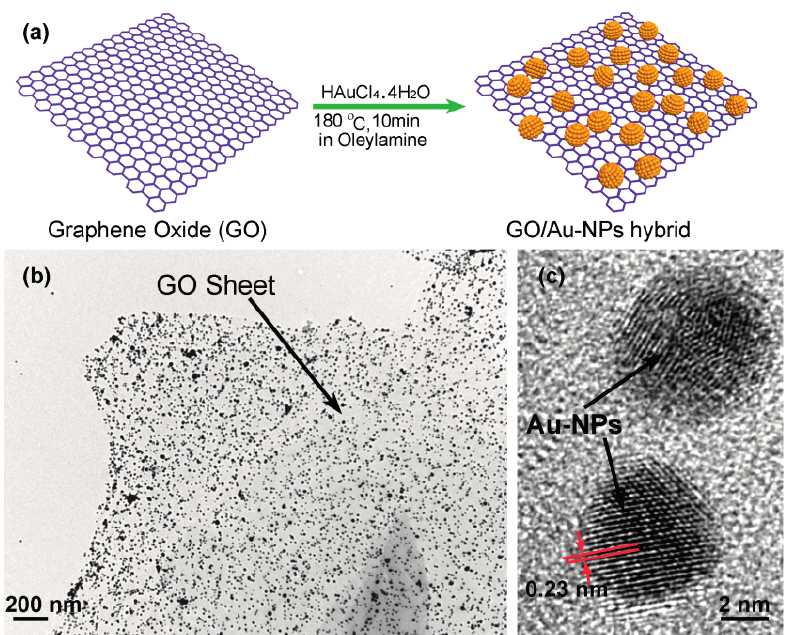
Figure 20. ( a ) Schematic process of Au-NPs grown on a GO sheet; ( b ) TEM image of the GO/Au-NPs hybrid; ( c ) High-resolution TEM (HR-TEM) image showing two Au-NPs on the GO sheet. Reprinted with permission from